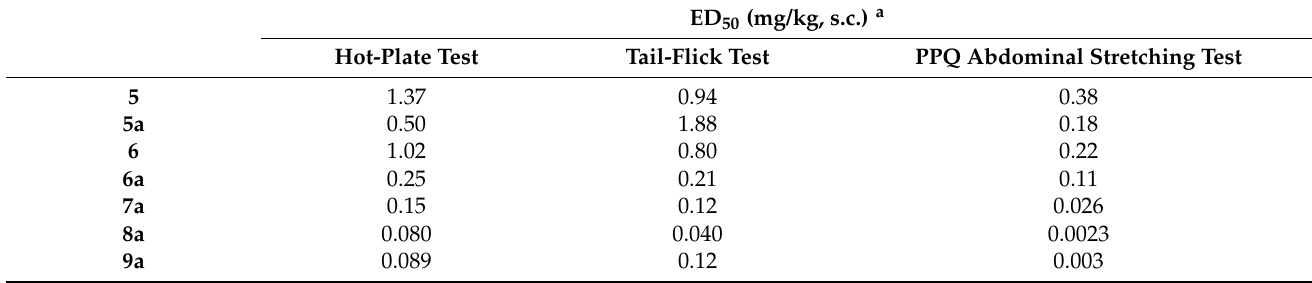
Table 3. Antinociceptive activities of N -methylmorphinan-6-ones 5 and 6 and their 6-CN substituted analogues 5a – 9a